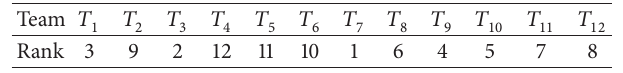
Table 4: Ranking results of 12 football